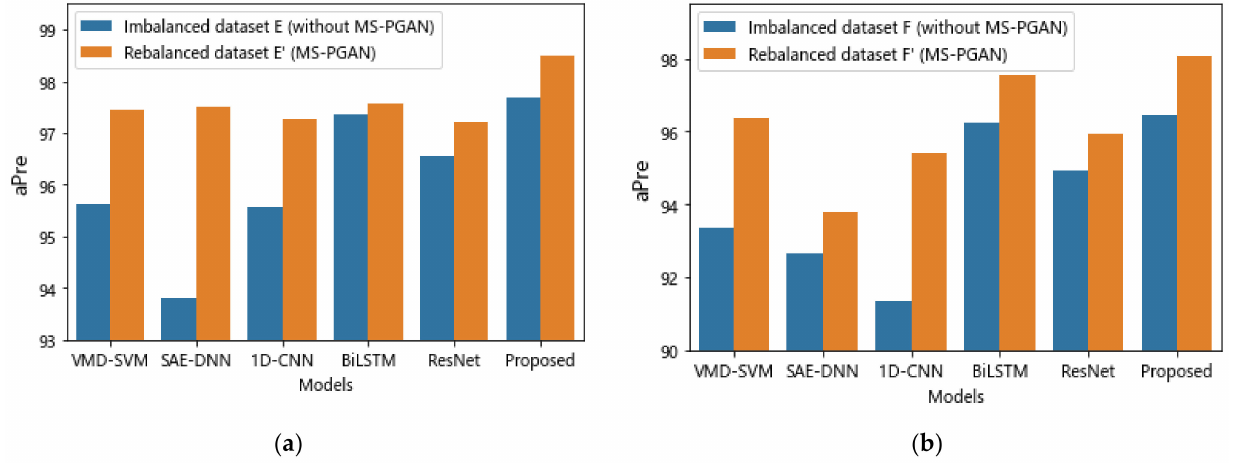
Figure 14. The average precision (%) of baselines and our proposed method for imbalanced data. ( a ) Results for Case 2 with a 0.1 imbalance ratio; ( b ) results for Case 2 with a 0.05 imbalance